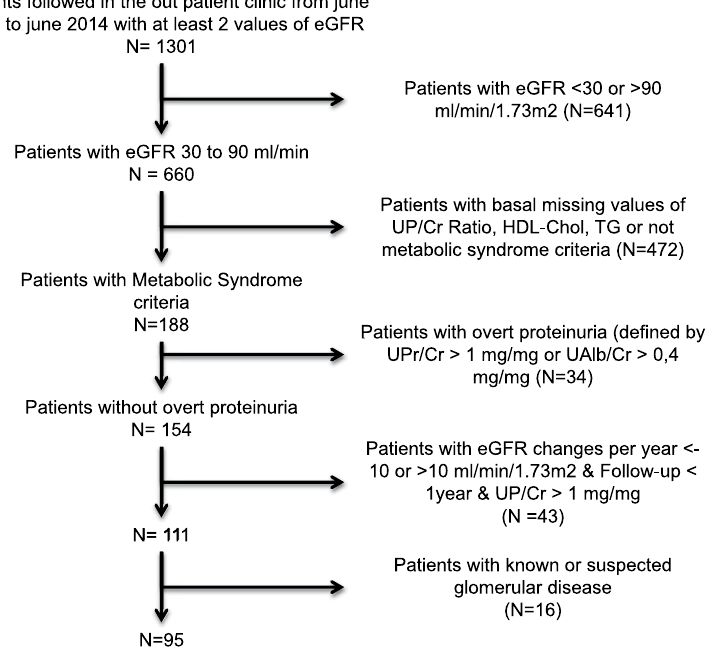
Figure 1. Flow chart showing details of how patients were selected. UP/Cr: Urinary Phosphate/creatinine; HDL-chol: High Density Lipoprotein Cholesterol; TG: Triglycerides, UPr/Cr: Urinary Protein/Creatinine; UAlb/Cr: Urinary